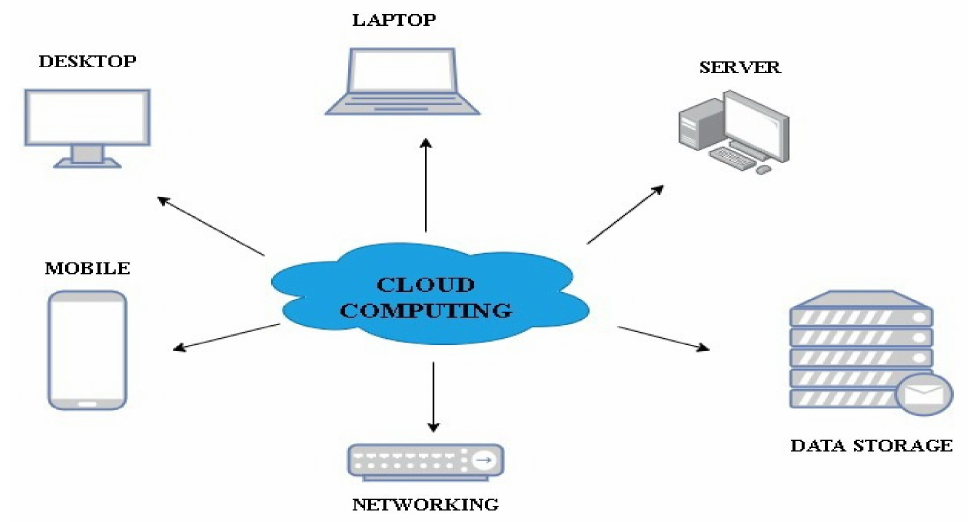
Figure 1. General cloud model representation.